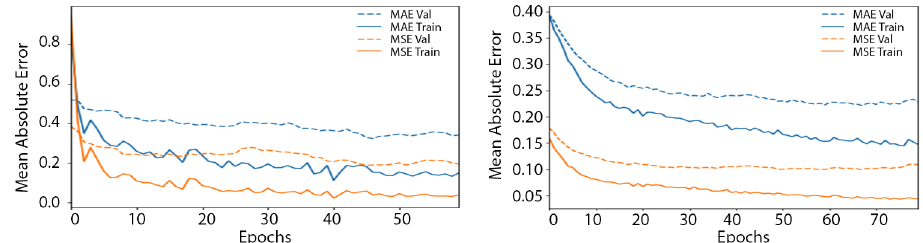
Figure 8. E5. LSTM (Long Short-Term Memory) for sequence of length 7 with error considering all predictions for the index during 2012–2018 (average MSE 0.04/0.09, MAE